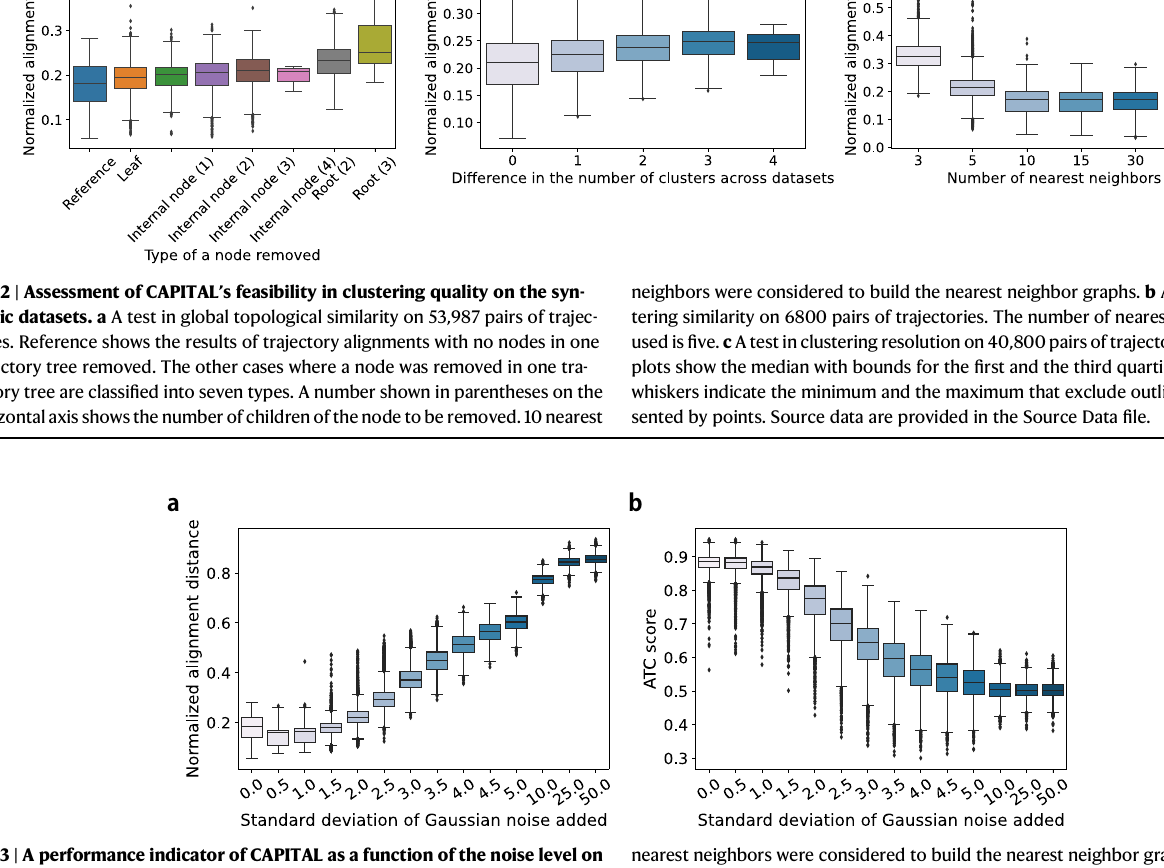
nearest neighbors were considered to build the nearest neighbor graphs in all the tests. The box plots show the median with bounds for the fi rst and the third quartiles, and the whiskers indicate the minimum and the maximum that exclude outliers represented by points. Source data are provided in the Source Data fi le. ATC average trajectory